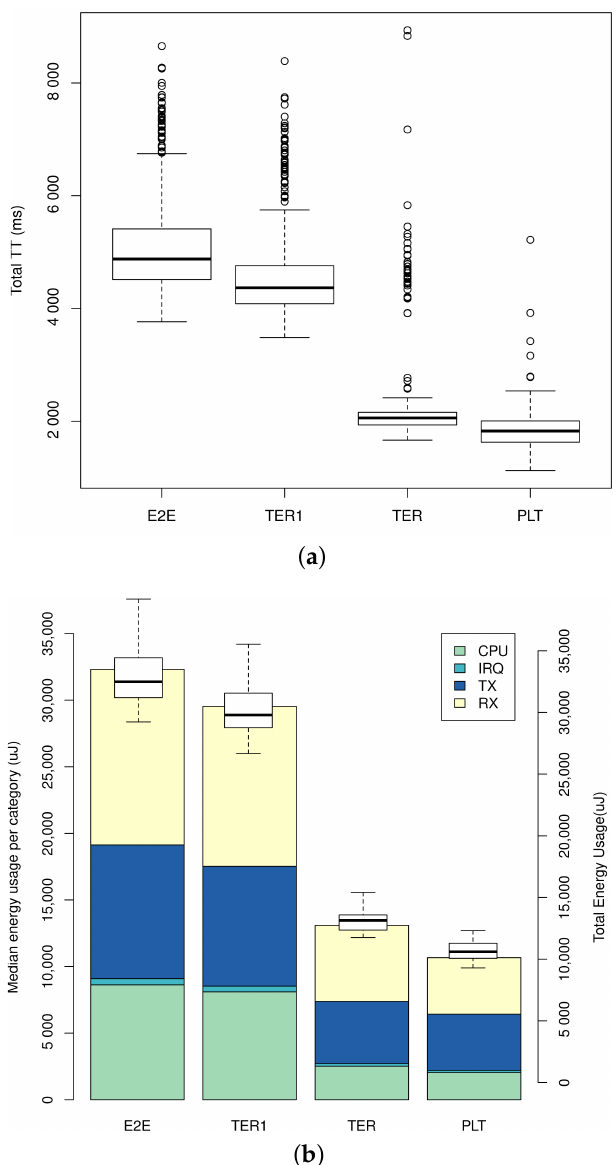
Figure 6. Transaction times and energy usage of the CoAPs servers for the three gateway configurations (End-to-End (E2E), first Termination (TER1), n -th Termination (TER)) and the Plain Text CoAP reference case (PLT). ( a ) Total Transaction Times (TTT) for the request sequence; ( b ) median energy usage per category (left axis) and total energy usage (right